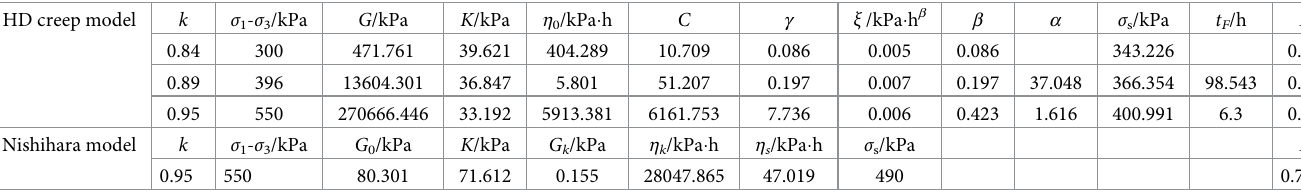
Table 4. Parameters determined through fitting the analysis based on creep tests of remoulded loess. HD creep